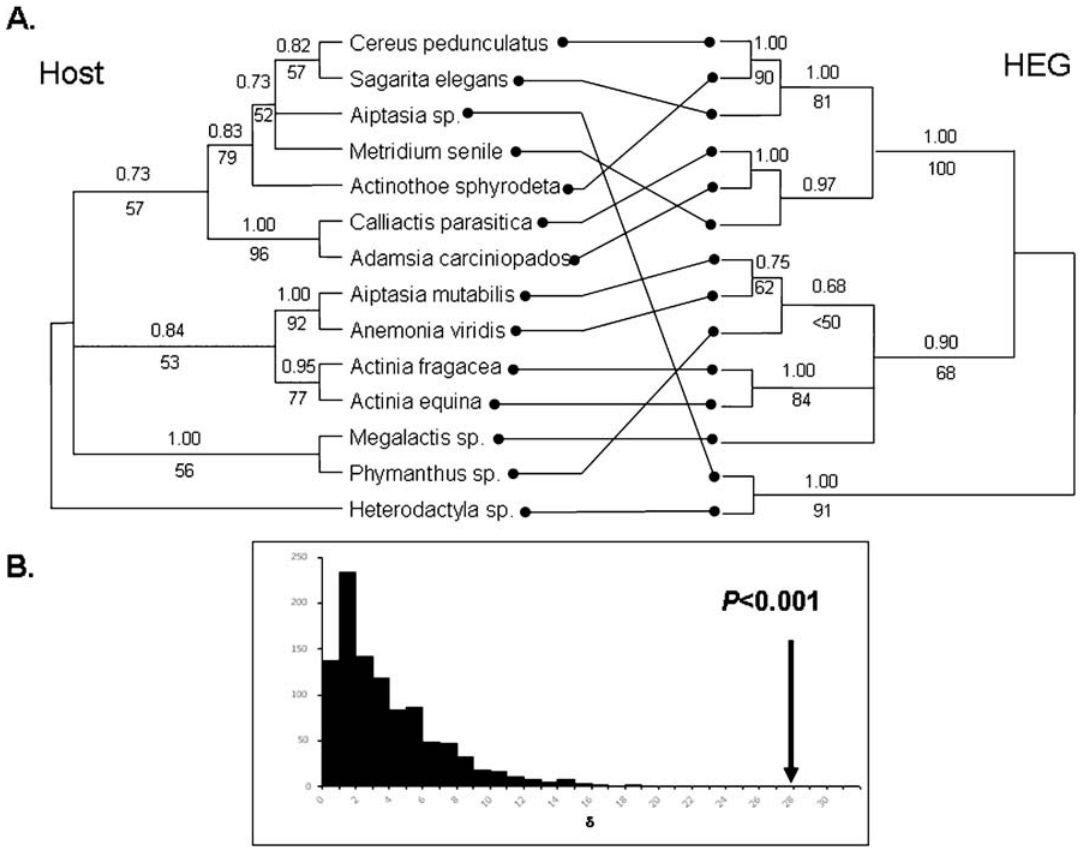
Figure 2. Comparison of Actinarian and HEG phylogenies. A. The numbers above each branch are the Bayesian posterior probabilities (again after burn-in trees discarded), and those below the branch are the support generated from a likelihood bootstrap analysis (n=1000). The HEG tree is unrooted (it is unknown) and displayed in such a way as to minimise the differences with the host tree. B. The null distribution for the likelihood ratio test generated by evaluating d for 1000 non-parametric bootstrap resampled data sets, 50% of which are drawn entirely from the host data and 50% from the HEG data. The likelihood ratio for the observed partition is shown.